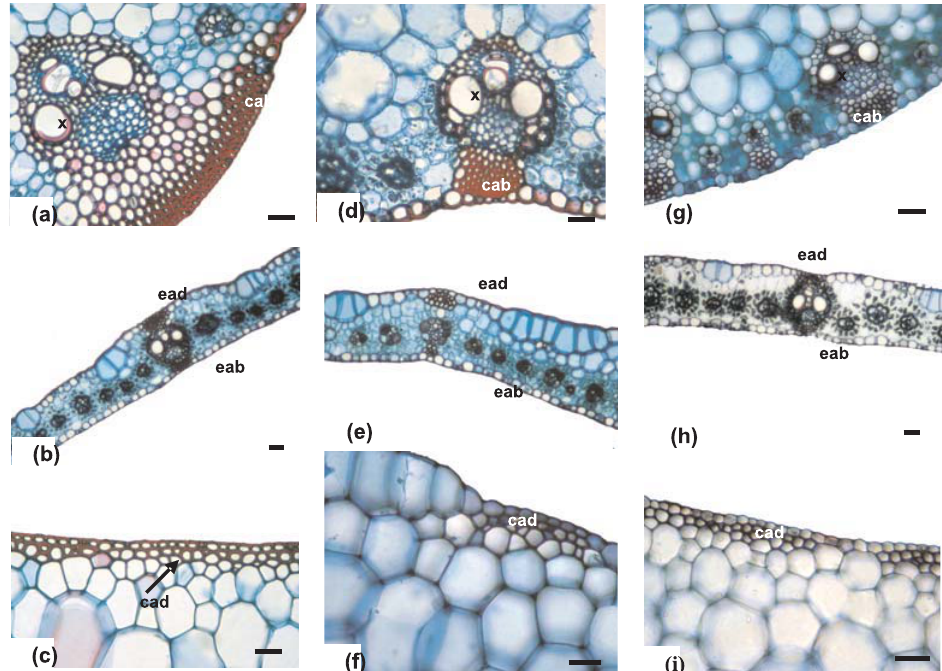
Figura 5. Alterações estruturais no tecido vascular, células epidérmicas e colenquimáticas de folhas de milho cultivadas em solo com doses crescentes de Zn. Folhas expostas a 150 mg kg -1 de Zn, (a) a (c) tratamento com calagem e (g) a (i) tratamento sem calagem; (d), folha exposta a 30 mg kg -1 ; (e) a